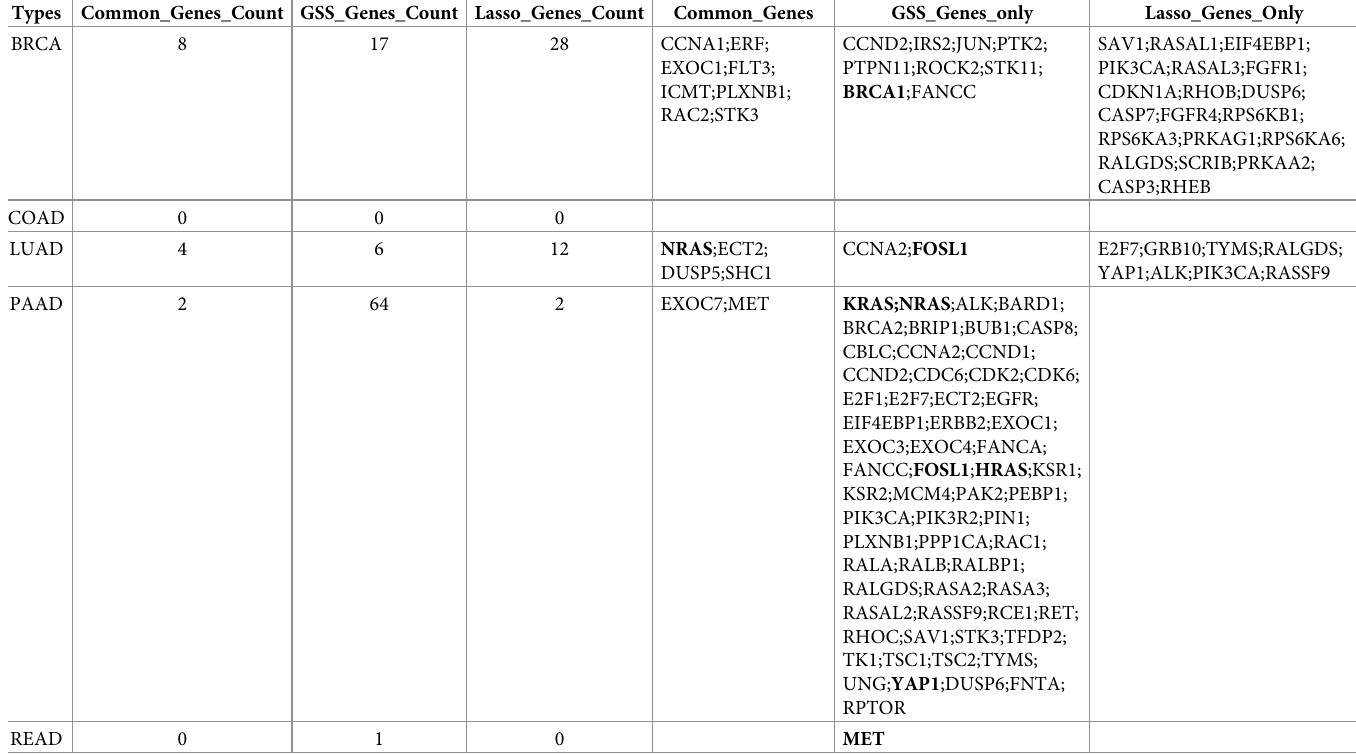
Comparison of results derived from GradientScanSurv (GSS) and Lasso methods with TCGA tuor data (adjusted p < = 0.05) for the association of survival outcome